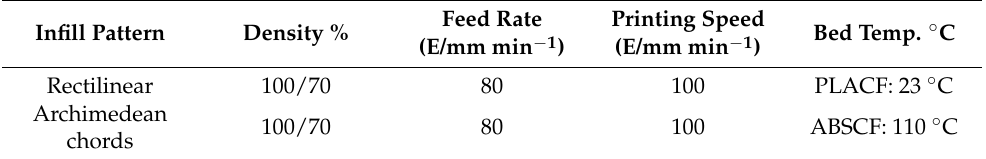
Figure 2. Schematic of using single head in manufacturing process. Table 2. Printing parameters.